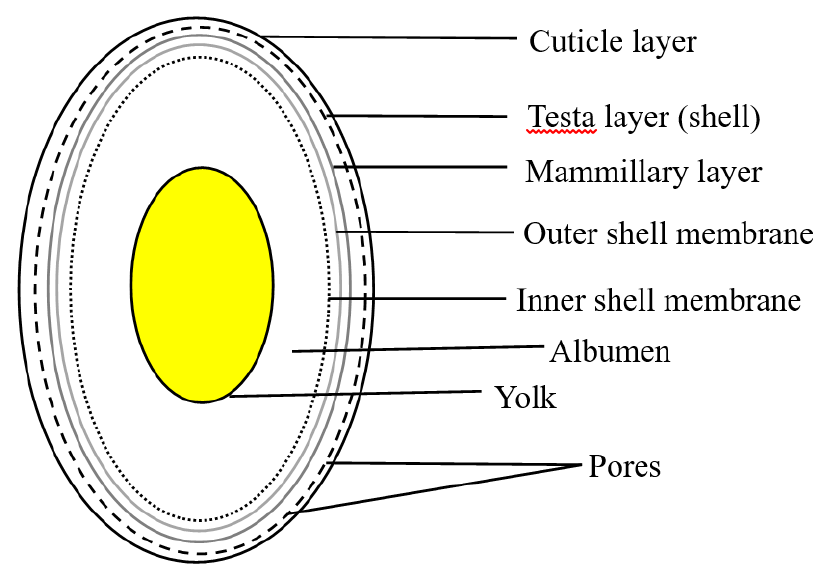
Figure 1. Structure of an eggshell.